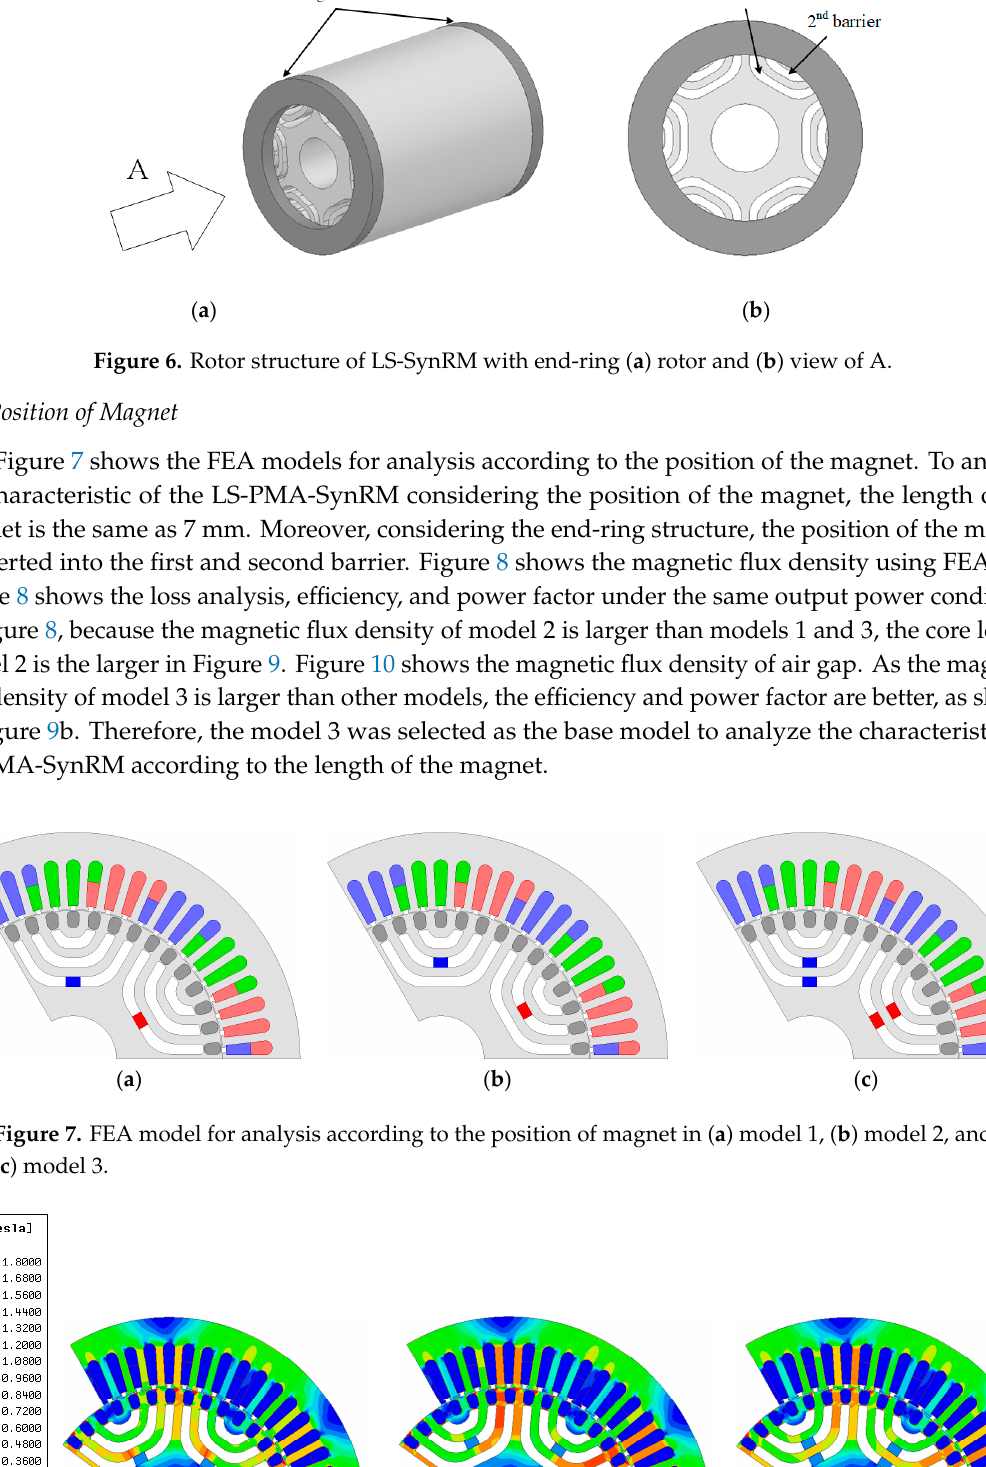
( b ) Figure 5. Electromagnetic analysis result of reference models: ( a ) IM, ( b ) LS-SynRM . Table 3. Characteristics of reference models using FEA. Item